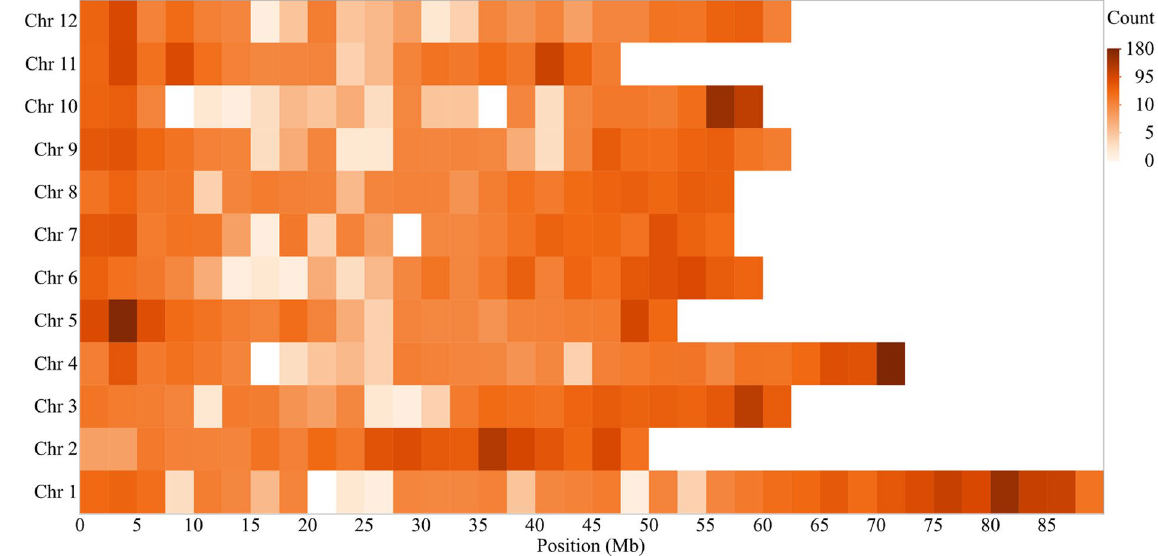
Figure 1. Heatmap of 10,106 SNPs across the twelve potato chromosomes. The color intensity indicates the density of markers in that segment of the chromosome (white, low density; maroon, high density). SNP density is shown to increase toward the ends of the chromosomes where gene density is